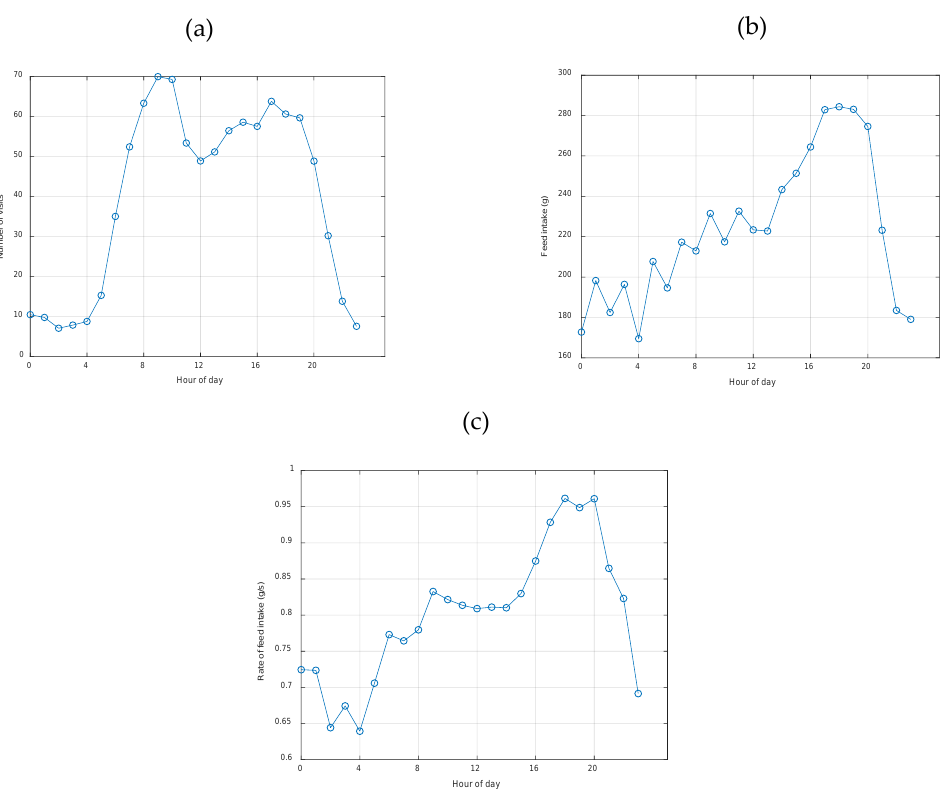
Figure 10. Diurnal distribution of ( a ) number of visits, ( b ) feed intake and ( c ) rate of feed intake parameters.